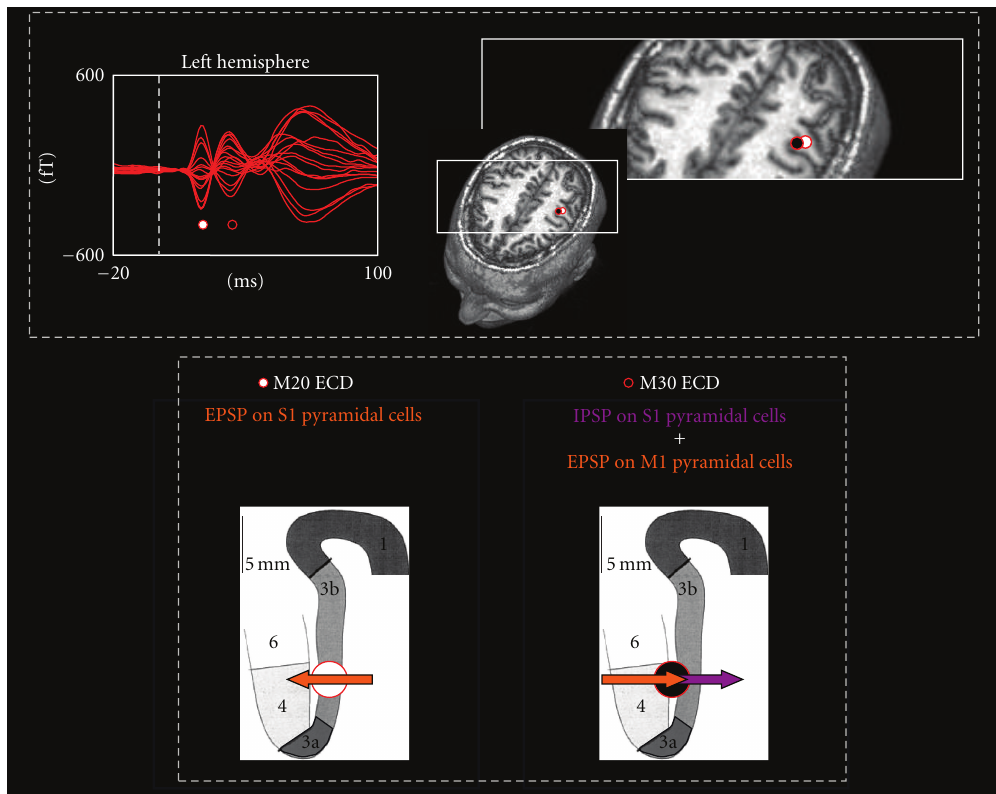
Figure 1: MEG primary sensorimotor cortex excitability indexes. Top left: in a representative subject, the superimposition of all left rolandic region channels in the [ − 20, 100] ms period, 0 being the moment of the galvanic stimulus arrival to the right median nerve at wrist. Top right: the position of the ECDs explaining the cerebral activation in correspondence to the M20 (white circle) and M30 (black circle) components is projected onto a suitable axial magnetic resonance image slice, through integration on the basis of individual anatomical landmarks. Bottom: schematic representation of currents subtending M20 and M30 generators in a suitable sagittal section of primary sensory and motor areas. Orange arrow indicates current induced by EPSP and purple arrow the e ff ect of IPSP. Circles represent the position of the corresponding equivalent current dipole. The M20 component is mainly generated by EPSPs impinging on pyramidal neurons in area 3b and is mediated by glutamate neurotransmitters. The currents associated with the IPSPs impinging on pyramidal neurons in 3b area are mediated by GABA neurotransmitter and are added to the EPSPs onto BA4 pyramidal neurons to give rise to M30